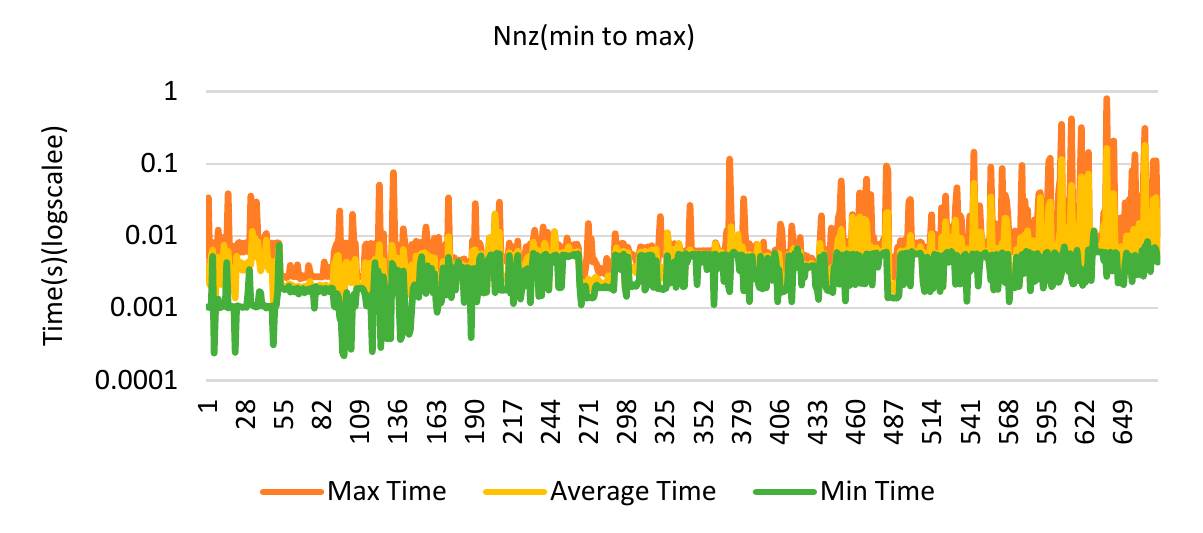
Figure 4. Execution time comparison of SpMV computation (dataset sorted by nnz -min to max). Figure 5 shows the comparison of execution time of the SpMV computation on the row-sorted data set (minimum to maximum). The X-axis shows the different matrices from various application domains sorted by row (minimum to maximum), and the Y-axis shows the execution time of SpMV computations on a logarithmic scale.